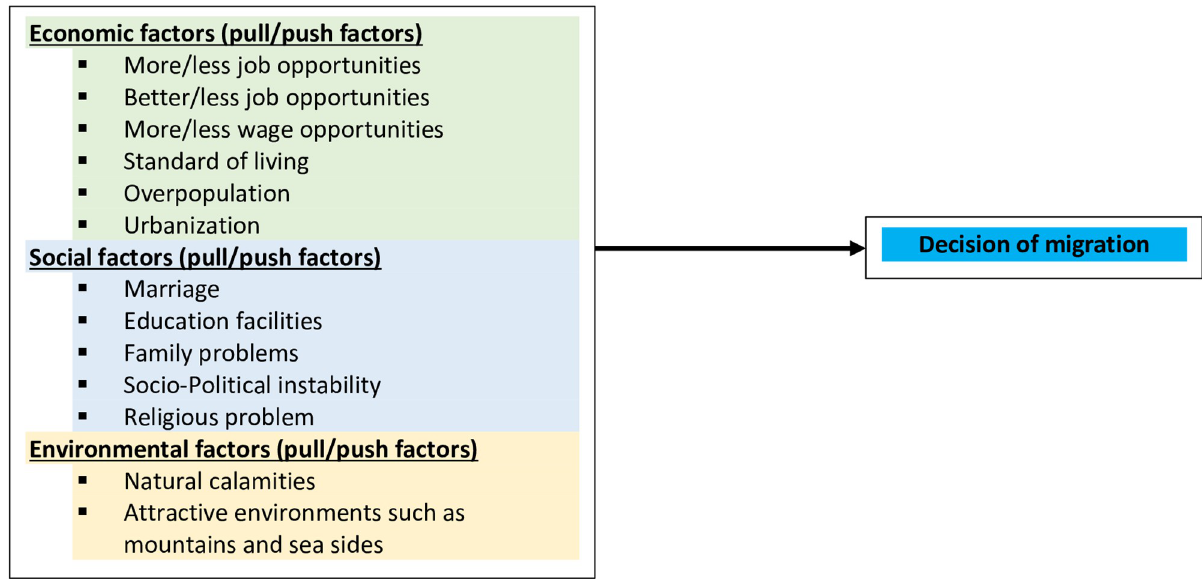
Fig 1. Conceptual framework of internal migration in Bangladesh. Source: The framework was produced using existing literature [2, 4, 7–11, 14, 18, 19, 22, 30, 31, 38].